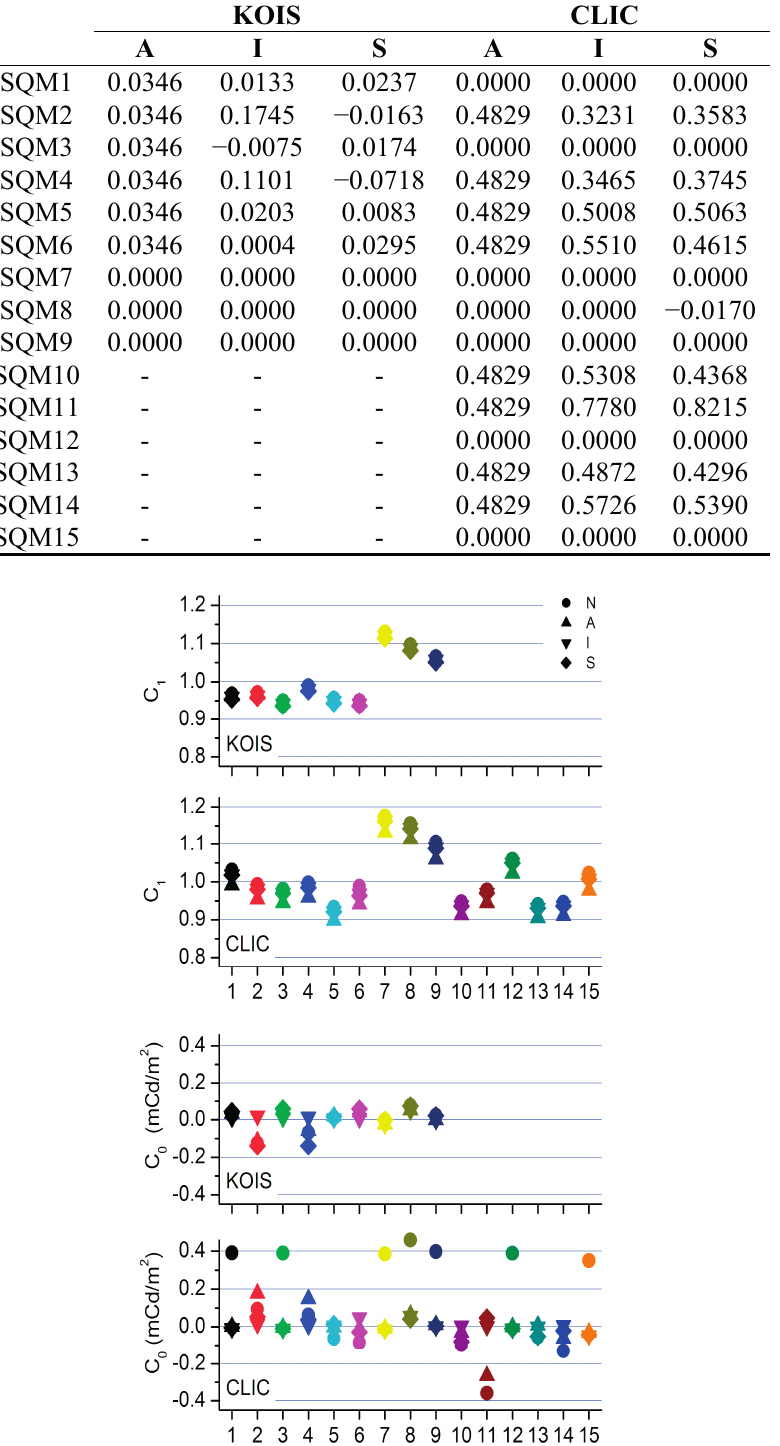
Table 3. Determined Offsets in (mcd/m 2 ).